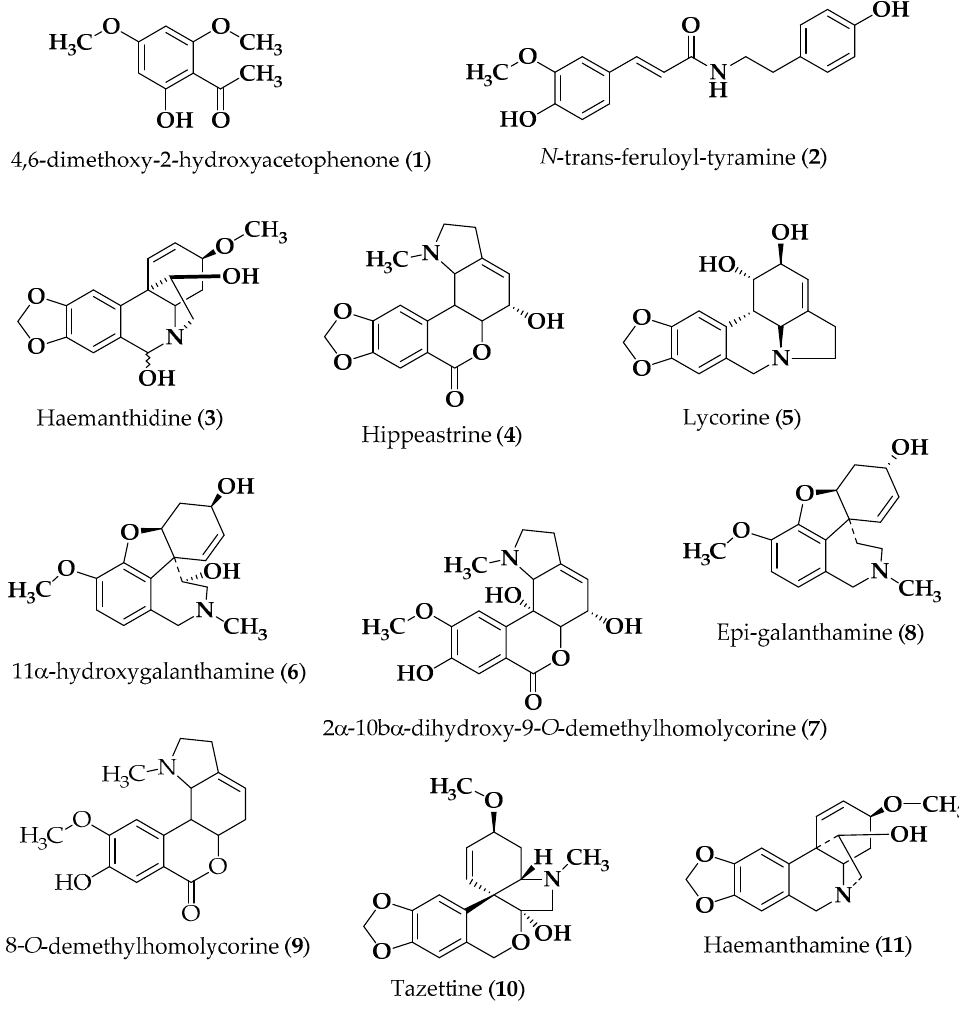
Figure 1. Chemical structures of compounds 1 – 11 .